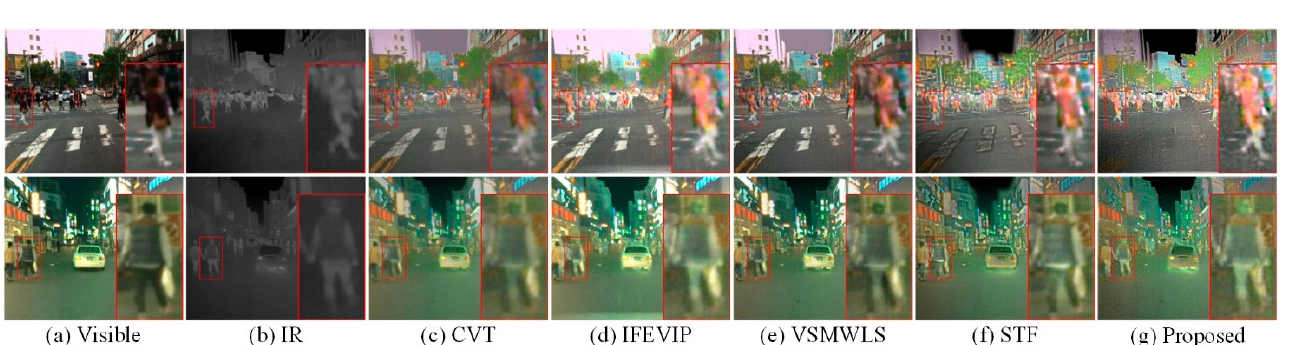
Figure 7. Fusion results of misaligned images. ( a ) shows the visible images; ( b ) shows the infrared images; ( c – g ) respectively show the fusion results based on CVT, IFEVIP, VSMWLS, STF and the proposed method.